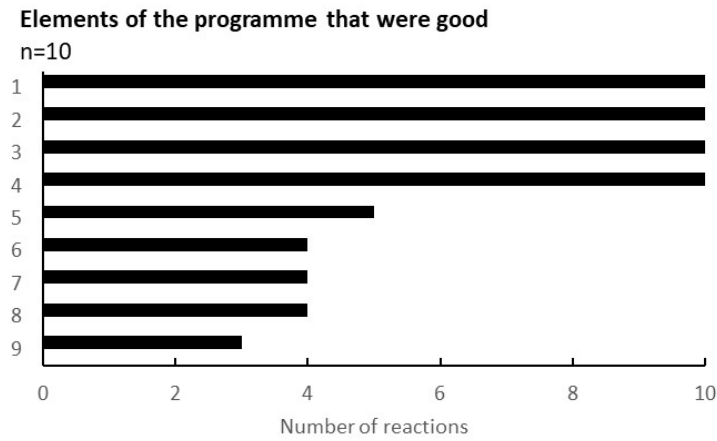
Figure 5. Elements of the programme that were good. The results were taken from the survey conducted during the eighth workshop. The vertical elements were as follows: 1, I could have my child taken care of safely; 2, I could have a health examination; 3, I could learn about the intestinal environment; 4, I could listen to others in a similar situation; 5, the workshop was held in my neighbourhood and it was easy to attend; 6, I could relate to the concept of ‘health & wealth’; 7, the workshop method was interesting; 8, They will listen to my stories and worries; 9, I could reconnect with previous participants.